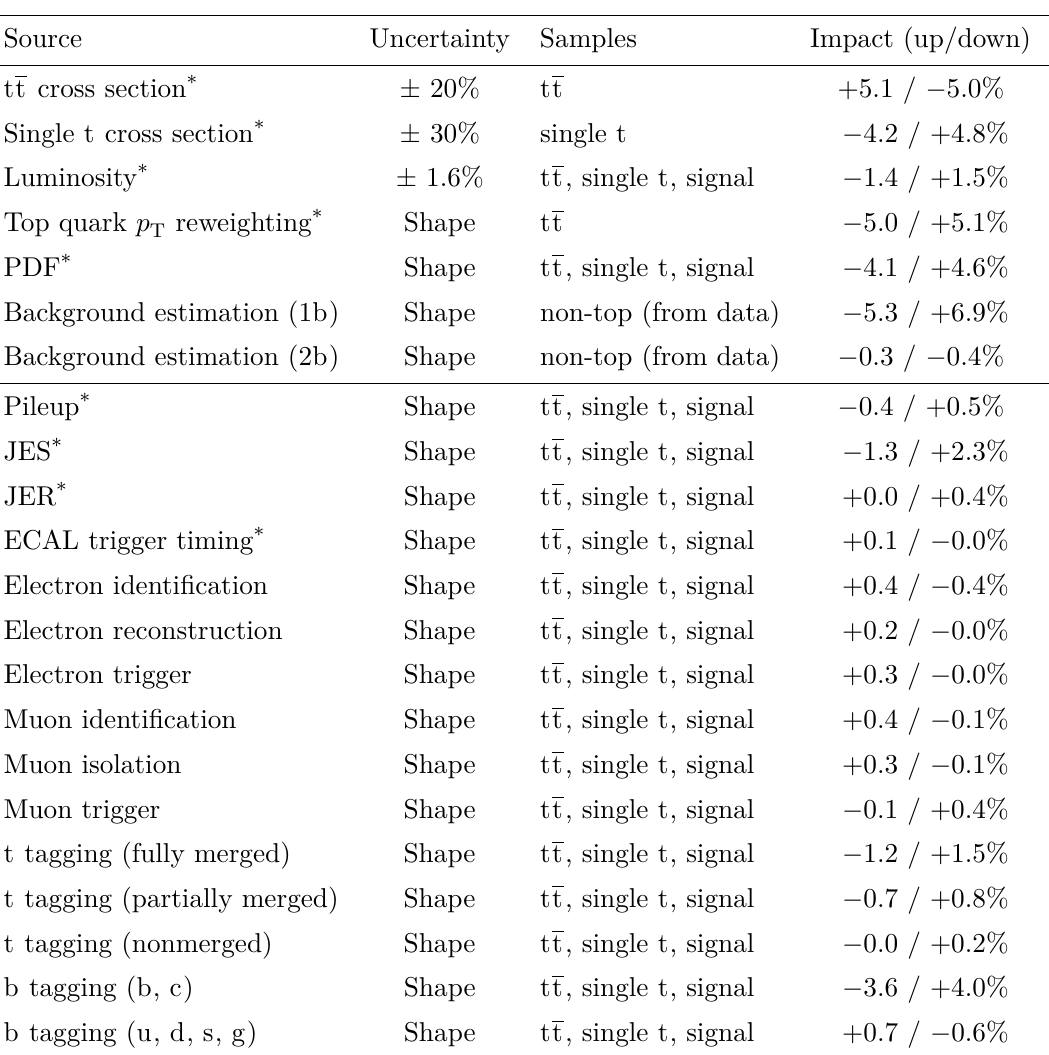
distri- Table 1 . Summary of all considered sources of systematic uncertainties affecting the M tW butions in the 1 b and 2 b categories of the ‘ +jets channel. The source of the uncertainty is given in the first column. The second column indicates if the uncertainty results in a change of normal- ization or shape of the M distribution. The samples affected by a given uncertainty source are tW shown in the third column. The fourth column shows the impact of these uncertainties, estimated for an LH b ∗ signal with a mass of 2.4 TeV. These are quantified by calculating the change in the fitted signal strength when a given parameter is displaced by ± 1 standard deviation from its post-fit value, divided by the total uncertainty in the fitted signal. Uncertainties taken to be fully correlated across the three years are given in the upper part of the table. Uncertainties affecting both the ‘ +jets and all-hadronic channels are marked by an